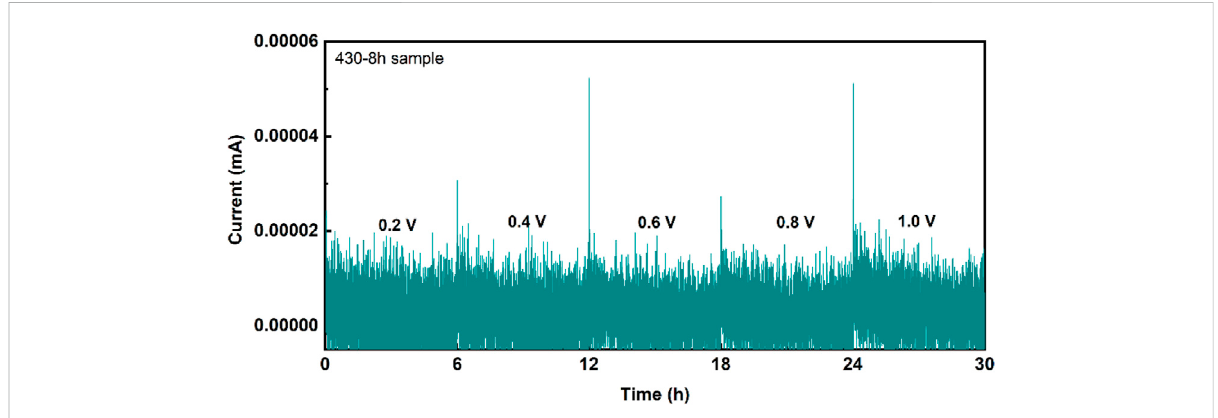
Figure 1B. The main peak at 484 cm − 1 for all samples is attributed to the stretching of PS 4 3 − (Wang et al., 2018) and indicates the presence of the high ionic conductivity phase Li 5.5 PS 4.5 Br 1.5 . The Raman results are in accordance with the XRD data